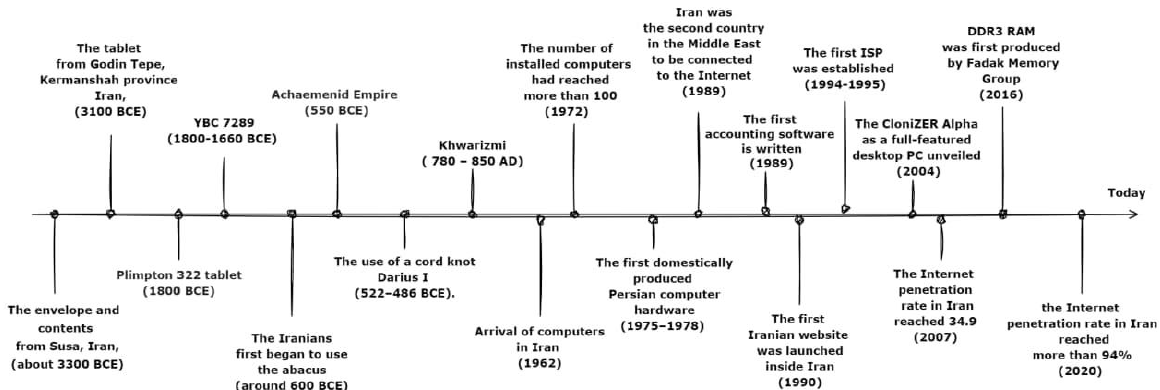
Figure 1. A timeline of significant computing events in Persia (Iran) from 3200 BCE until 2020 (not-